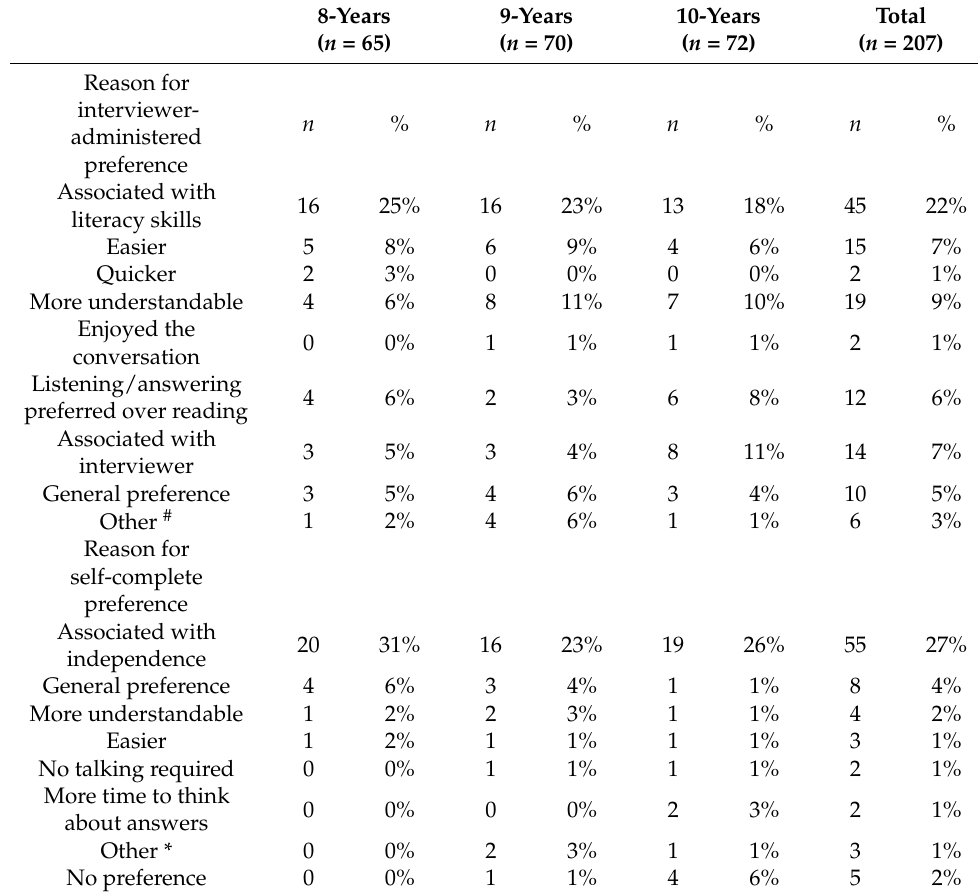
Table 8. Reason for preference between the self-complete and interviewer-administered